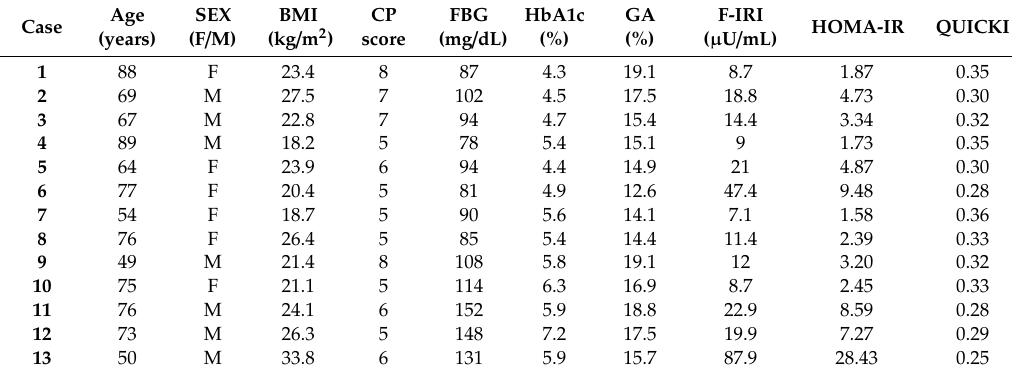
Table 2. Clinical profiles of patients with cirrhosis.